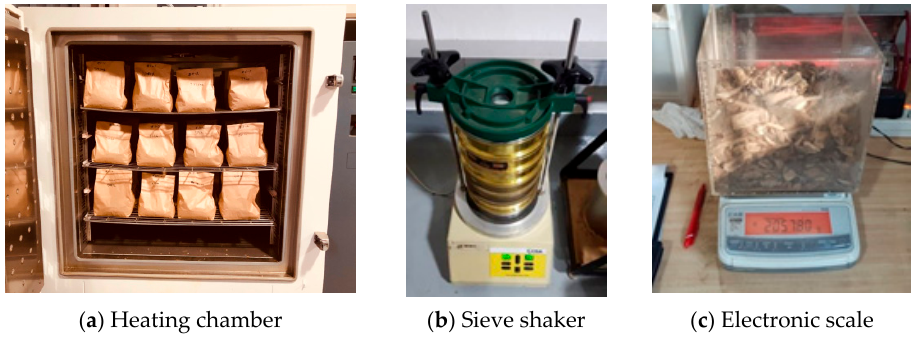
Figure 4. Measurement equipment for wood chips’ particle size distribution.